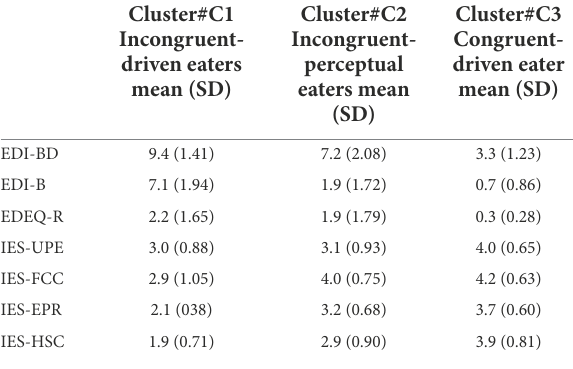
TABLE 1 Body perceptions and attitudes and eating behaviors by cluster.